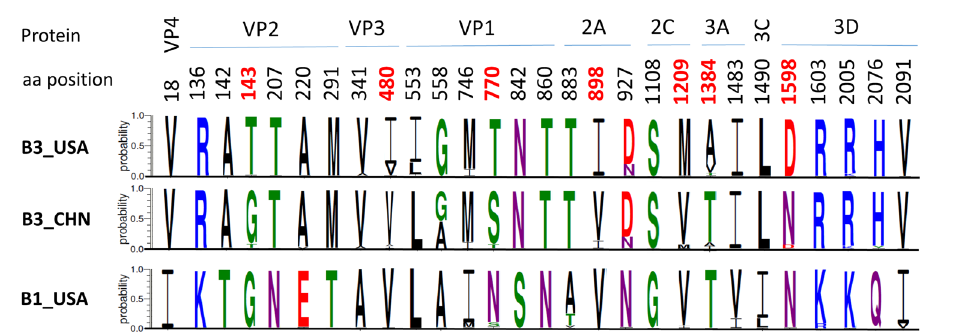
Figure 4. Amino acid (aa) polymorphisms of Enterovirus D68 subclade B3 based on the entire polypeptide sequences of approximate 2,190 aa. Twenty-eight amino acid polymorphisms were identified in subclade B3 strains from the US in 2016, as compared to those of subclade B1 strains from US in 2014. Of these, 7 amino acid substitutions that were first described in this report are highlighted in red with corresponding amino acid position numbers. See Fig. 3 for a list of subclade B3 strains included (n = 50). Twenty subclade B1 strains from New York in 2014 were used to generate the graphic presentation for the B1_USA. Amino acid position was based on the EV-D68 subclade B1 strain NY120 (accession